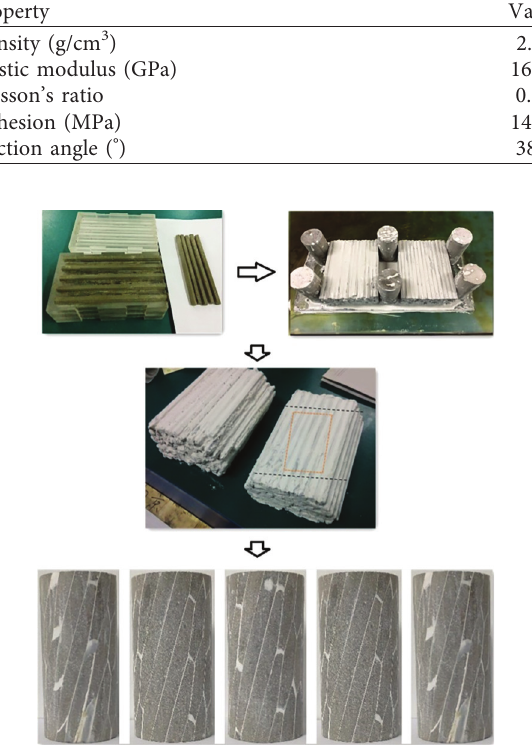
Figure 1: Production procedure of CJRM-like material samples. Table 2: Physical and geometric parameters of CJRM-like material samples.